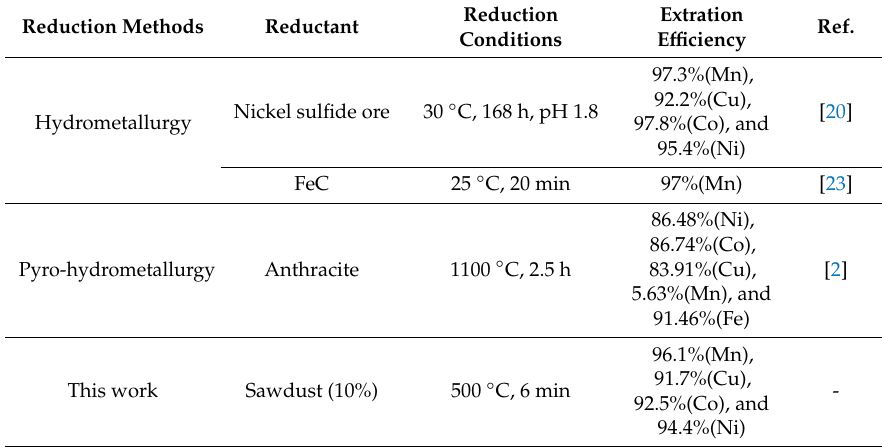
Table 5. A comparison of performances for the reduction of ocean manganese nodules, including results from the literature and this